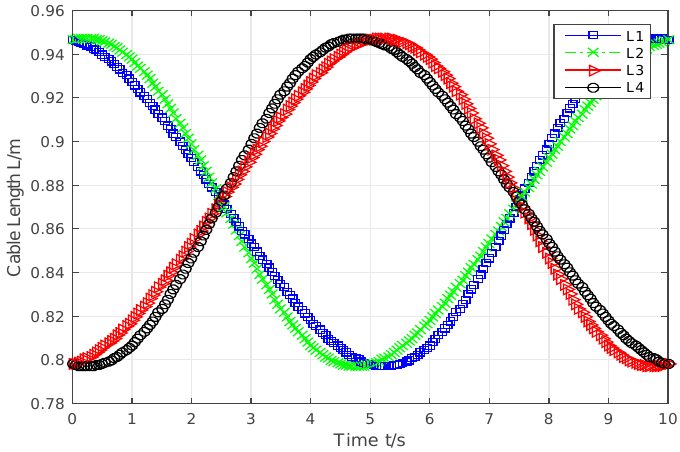
Figure 10. The change of the cables’ lengths.